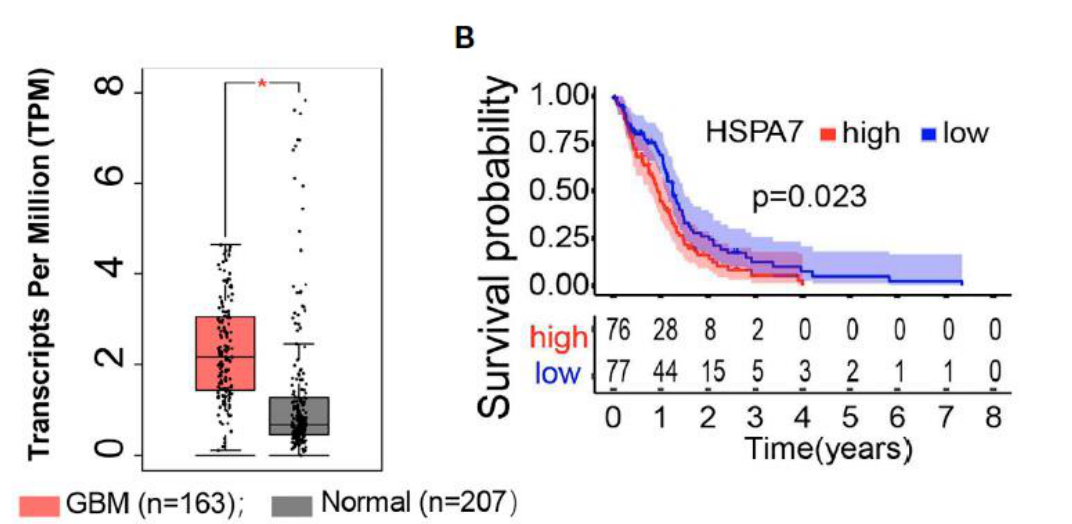
Figure 7. HSPA7 as a novel prognostic factor in GBM. ( A ) The GEPIA database showed that HSAP7 was overexpressed significantly in GBM tissues compared with GETx normal brain tissues. ( B )